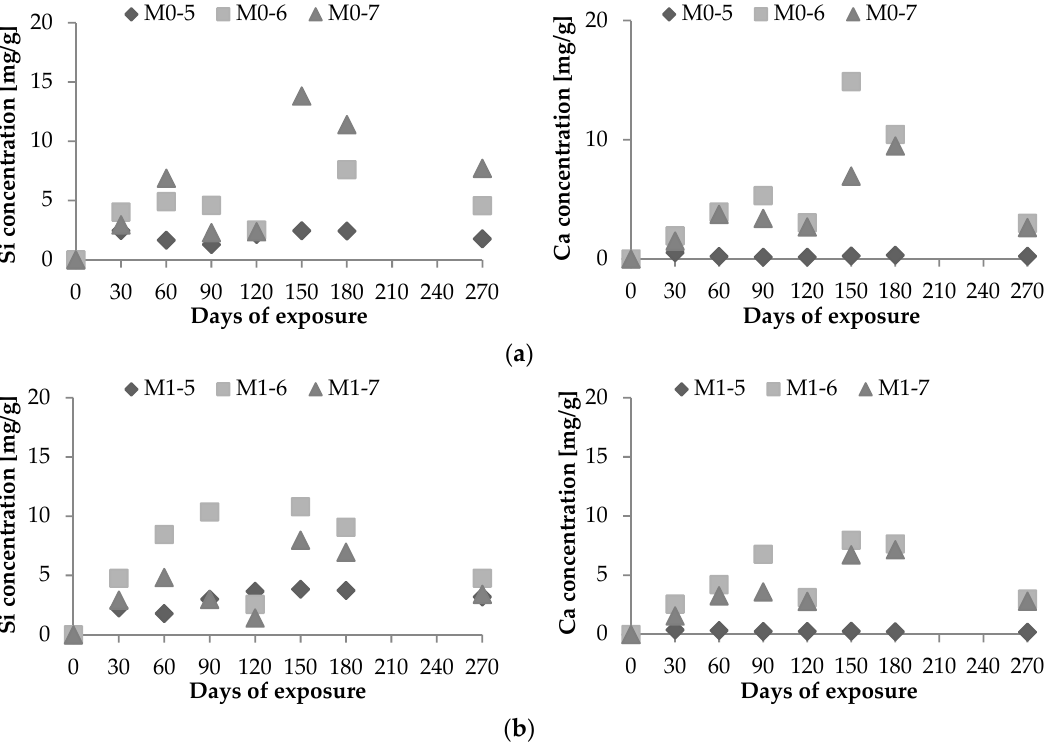
Figure 4. Dissolved Si 4+ and Ca 2+ corresponding to 1 g of concrete samples ( a ) without and ( b ) with the addition of silica fume.